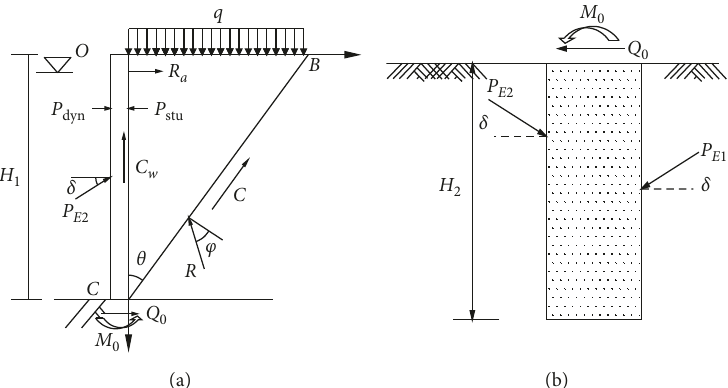
Figure 4: Calculation diagrammatic sketch of front wall’s displacement under earthquakes. (a) The front wall above soil surface. (b) The front wall below soil